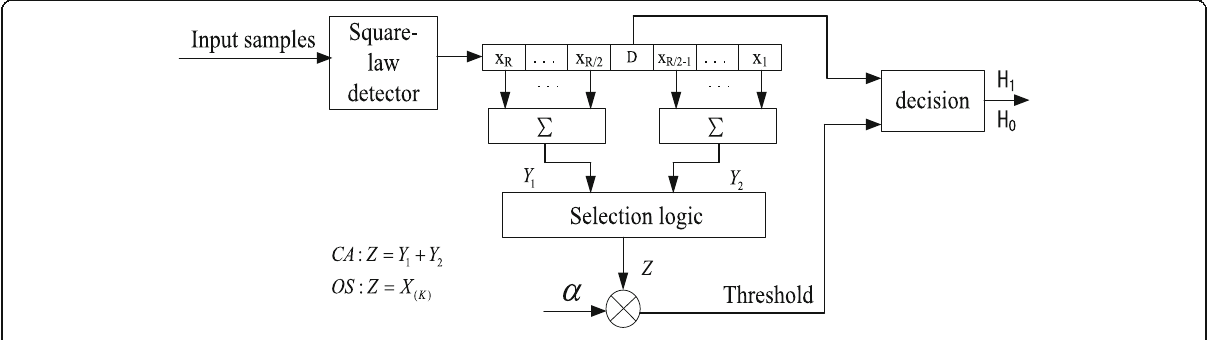
Fig. 1 Block diagram of the CA-CFAR and OS-CFAR